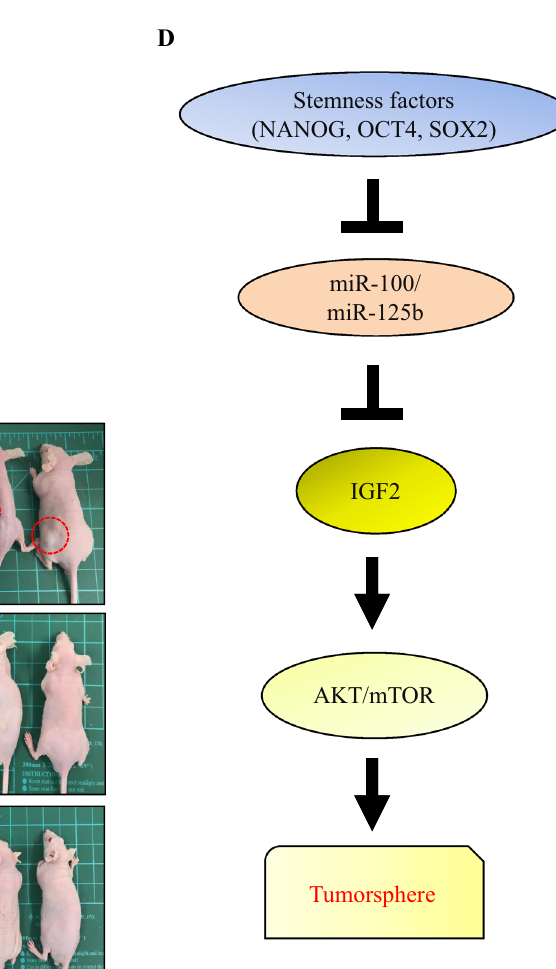
Figure 6. miR-100 and -125b overexpression attenuates liver tumor growth in vivo. ( A ) Fluorescence microscopy examination of Hep3B cells transfected with lentiviral vectors. GFP expression was observed by fluorescence microscopy. Hep3B cells infected with CD513B-control vector or CD513B miR-100b mimic or CD513B miR-125b mimic were detected as green fluorescence in dark field microscopy. Images were taken with an Carl Zeiss Axio Observer.Z1 fluorescence microscope using ZEN software. ( B ) Immunoblots for IGF2 protein in spheres with CD513B-miR-100 or miR-125b mimic. Control vector-transduced cells were used as a control. β-actin was used as an internal control. Blots were cropped to show specific bands. ( C ) Representative images showing the sizes of tumors injected with miR-NC or miR-100, -125b at 30 days. ( D ) Proposed model illustrating the mechanism of miR-100HG in regulating IGF2 and cancer stem cell (CSC) properties in hepatocellular carcinoma